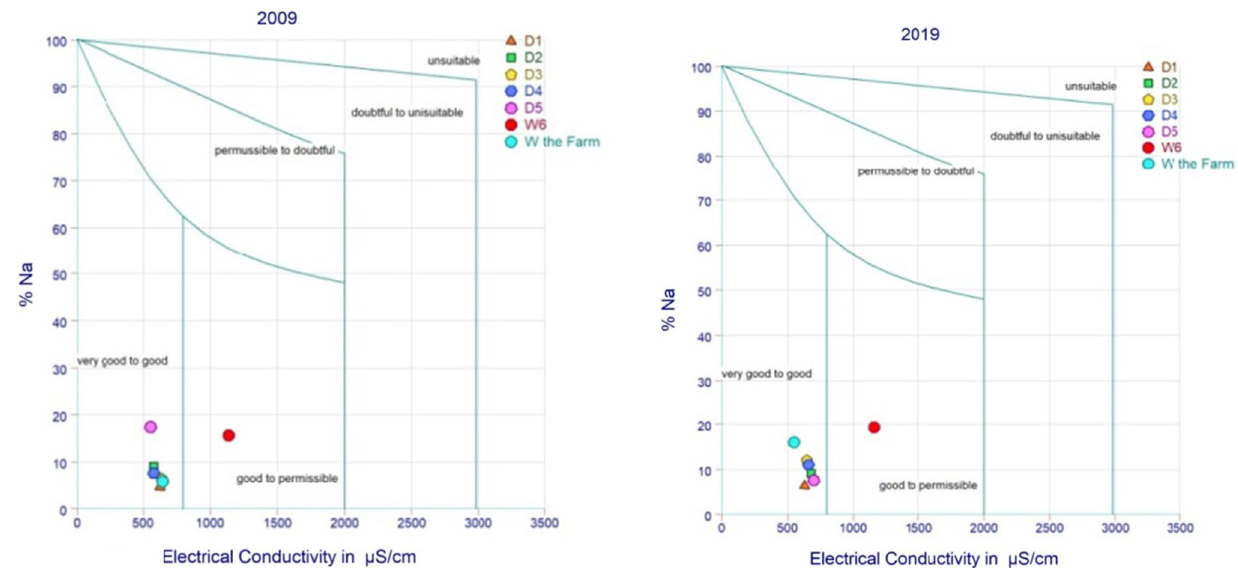
Fig. 4 Illustration of ESP of groundwater samples of the Mougheul area (2009–2019), using the Diagram software of the Avignon Hydrogeol- ogy Laboratory (Roland Simler 2003–2019) version 6.6